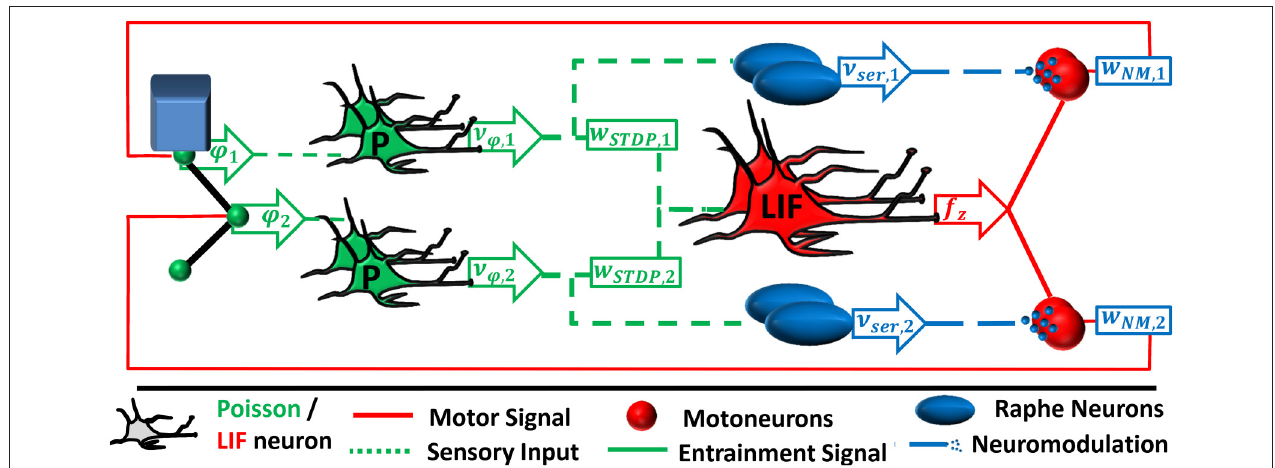
FIGURE 4 | The neural feedback network is an extended version of the feed-forward network as described in Figure 2. In contrast, the spinal interneurons are implemented as leaky integrate-and-fire (LIF) neurons. Their pool averaged firing rate is proportionally transformed into a motor signal f z . The motor signal is amplified by a factor w NM , i due to serotonergic neuromodulation and is projected back to the muscles.